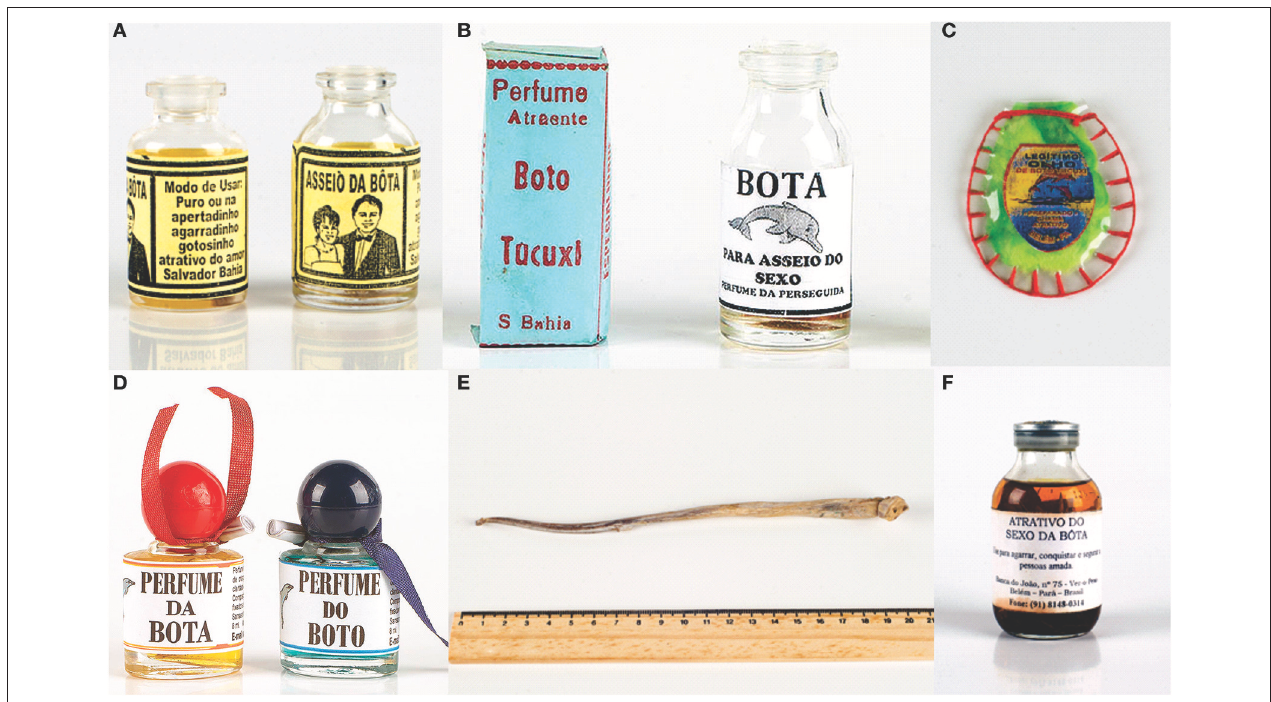
FIGURE 2 | Love charm samples. (A) “Dolphin perfume charm” from São Luís, Maranhão state, (B) “Dolphin sex attractive” from Bragança, Pará state, (C) Eye dolphin from Bragança, Pará state; (D) “Dolphin perfume charm” from Tijuca, Rio de Janeiro, Rio de Janeiro state, (E) Dried penis from Mercadão de Madureira, Rio de Janeiro, Rio de Janeiro state, (F) “Dolphin sex attractive” from Ver-o-Peso Market, Belém, Pará state.